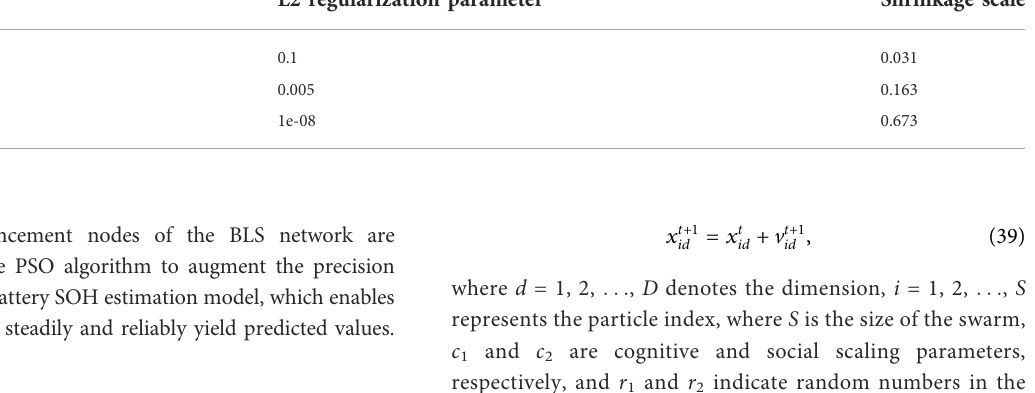
TABLE 3 The optimized parameters of the BLS network by PSO